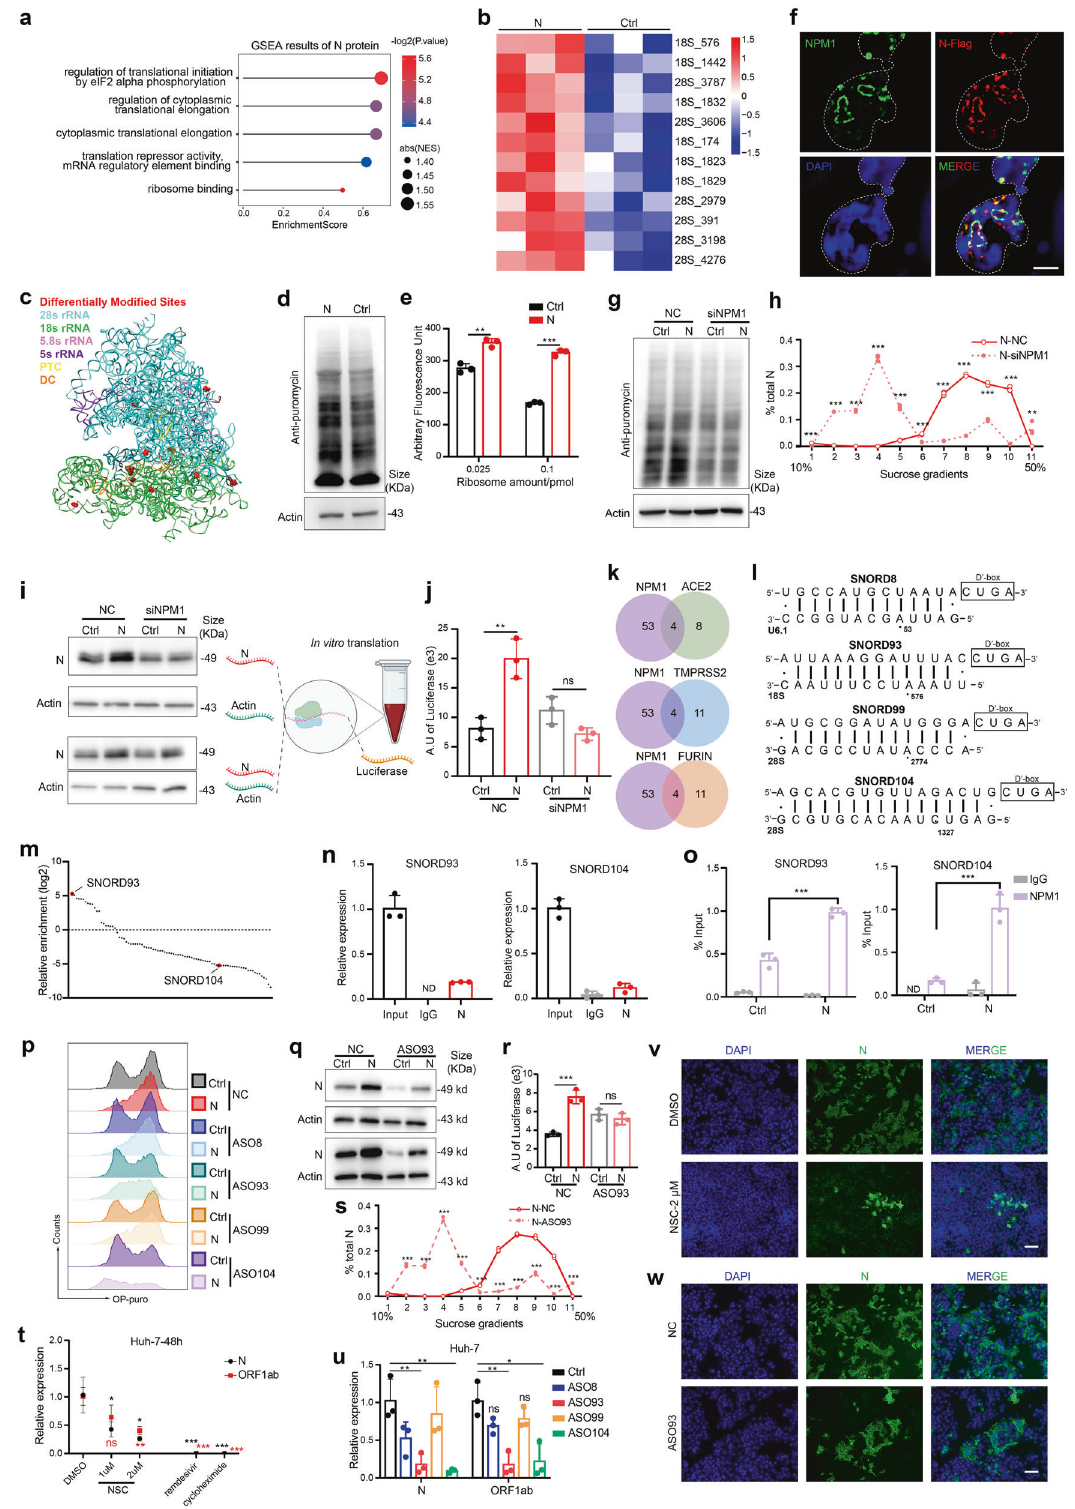
(Fig. 1k, l, Supplementary Fig. S6d). Exploiting published data, we also found that SNORD93 was the most highly enriched, among snoRNAs bound to N protein 5 (Fig. 1m). This was veri fi ed by RNA immunoprecipitation (Fig. 1n and Supplementary S6e). Besides, we found that N protein signi fi cantly promoted binding of